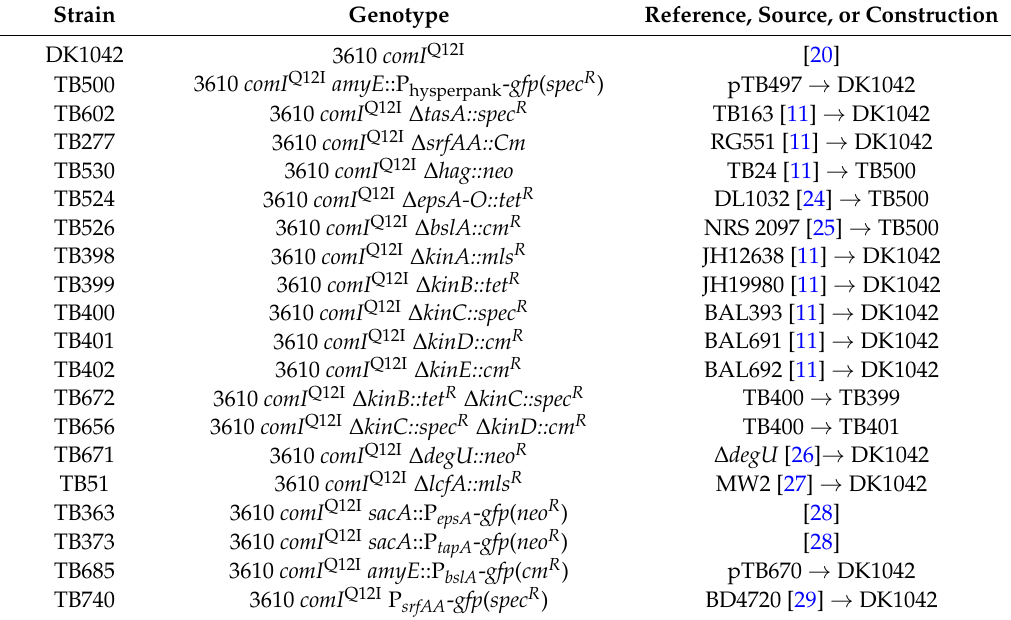
Table 1. Strains used in the